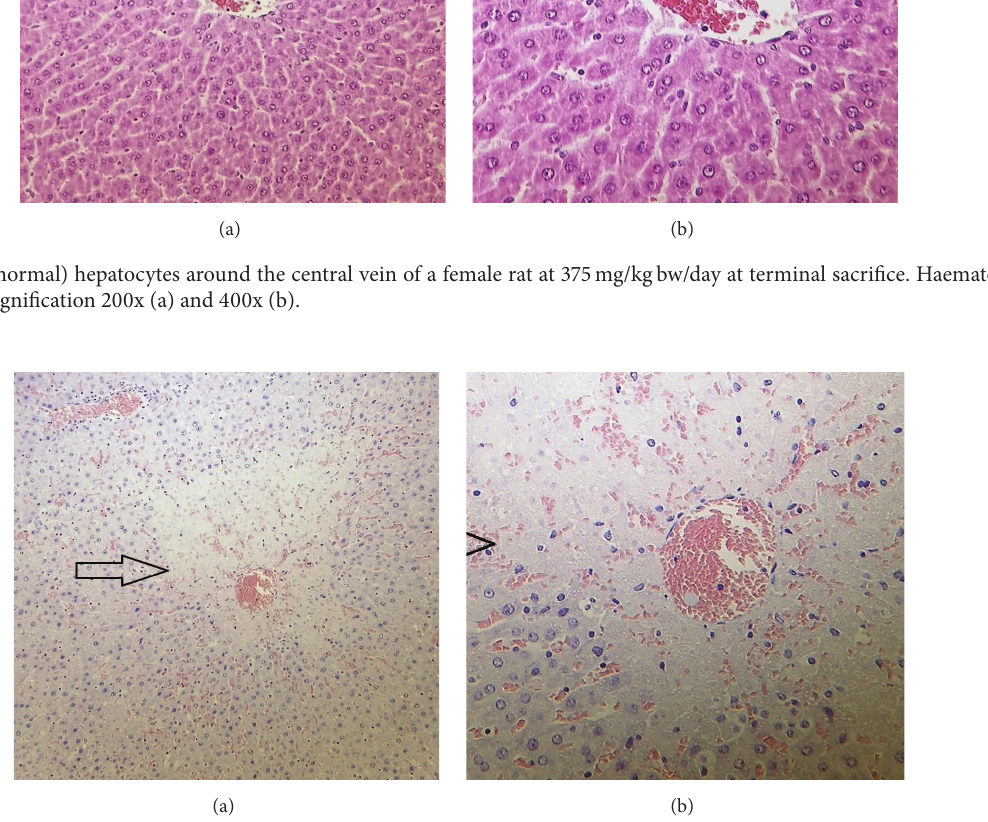
Figure 2: Centrilobular necrosis (arrows) in the liver of a female rat at 300mg/kg bw/day found dead on day 33. Haematoxylin and eosin staining; magnification 200x (a) and 400x